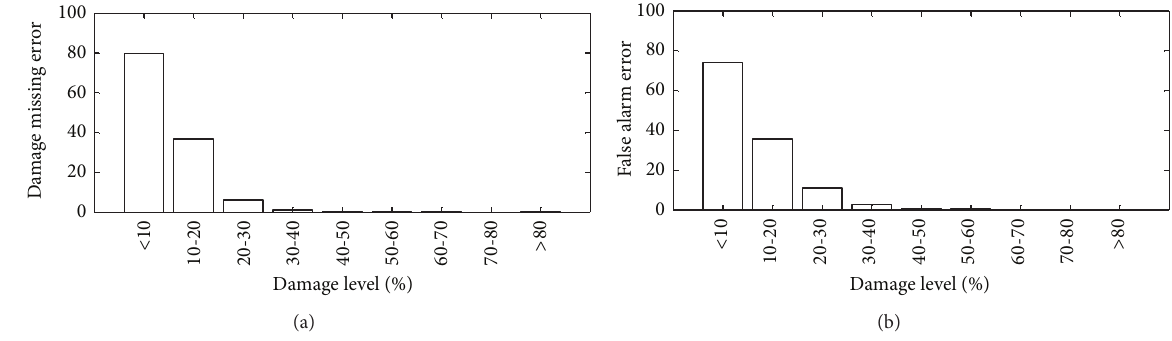
Figure 7: Damage missing error (DME) and false alarm error (FAE) for different damage levels.